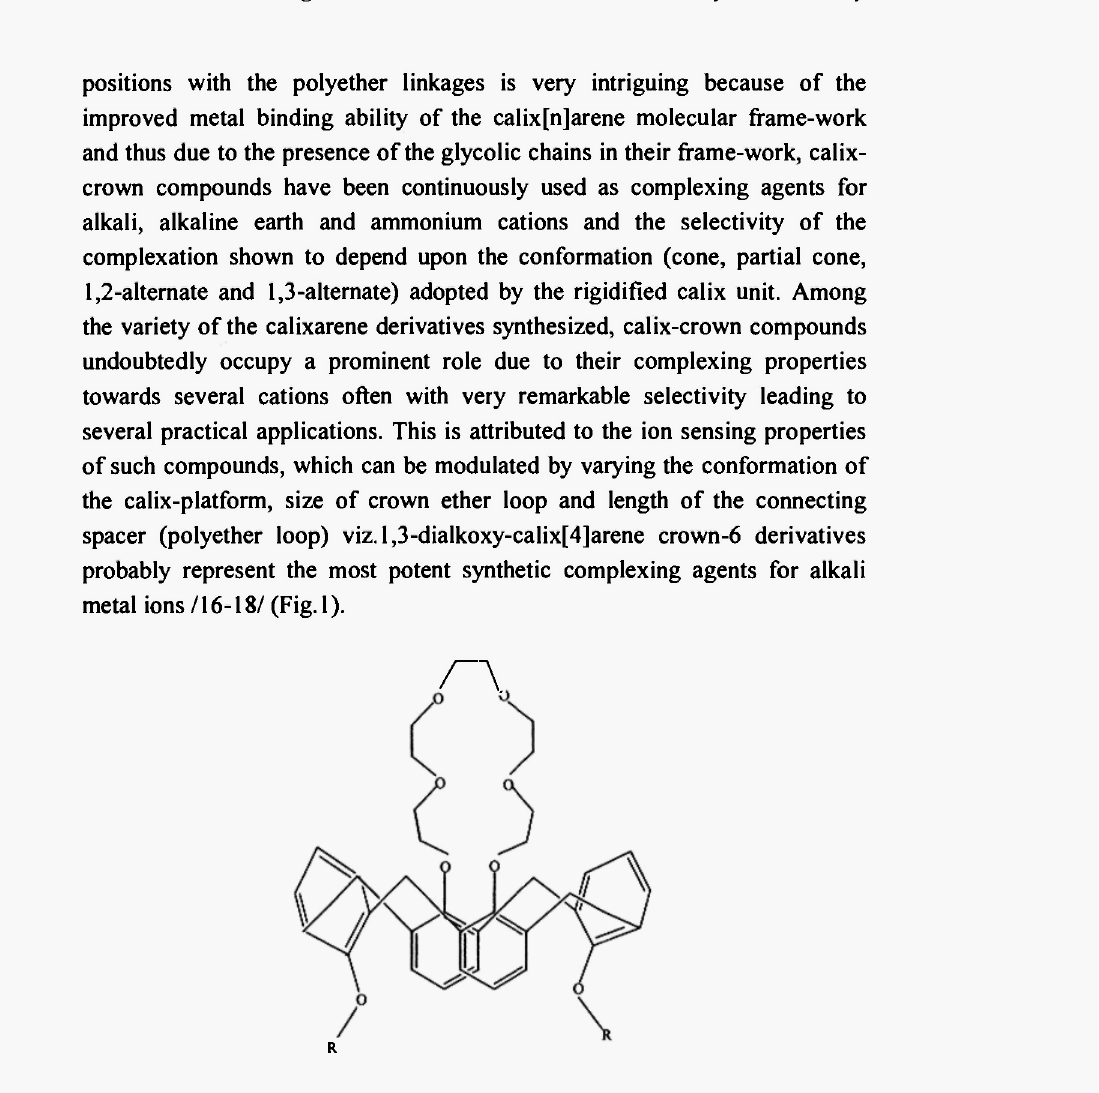
Fig. 1: 1,3-alternate